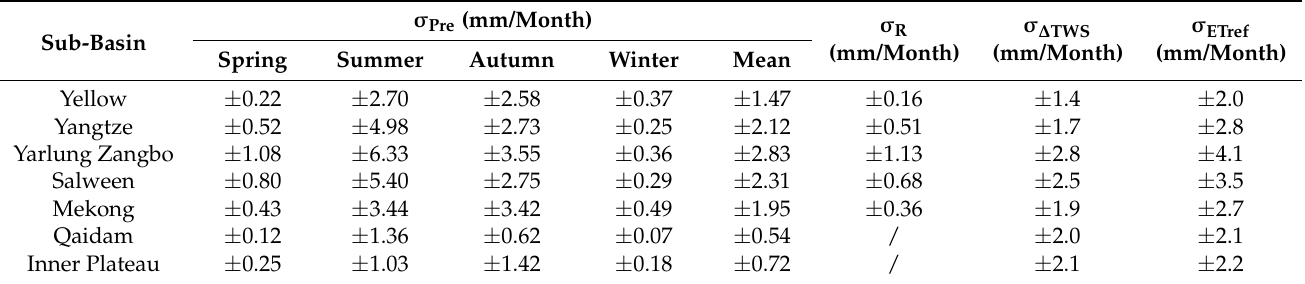
Table 3. Uncertainty Estimates of Different Components for the